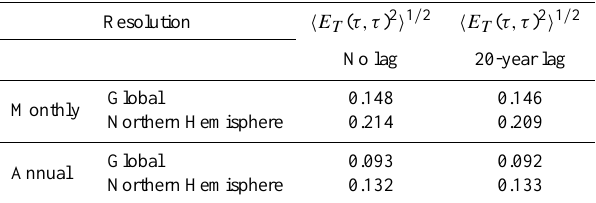
Table 4. The hindcast standard deviations (in K) at the finest res- olutions (1 month, 1 year) for natural variability temperatures ob- tained from the unlagged and 20-year lagged climate sensitivities. Note that the lag makes very little difference to the hindcast error